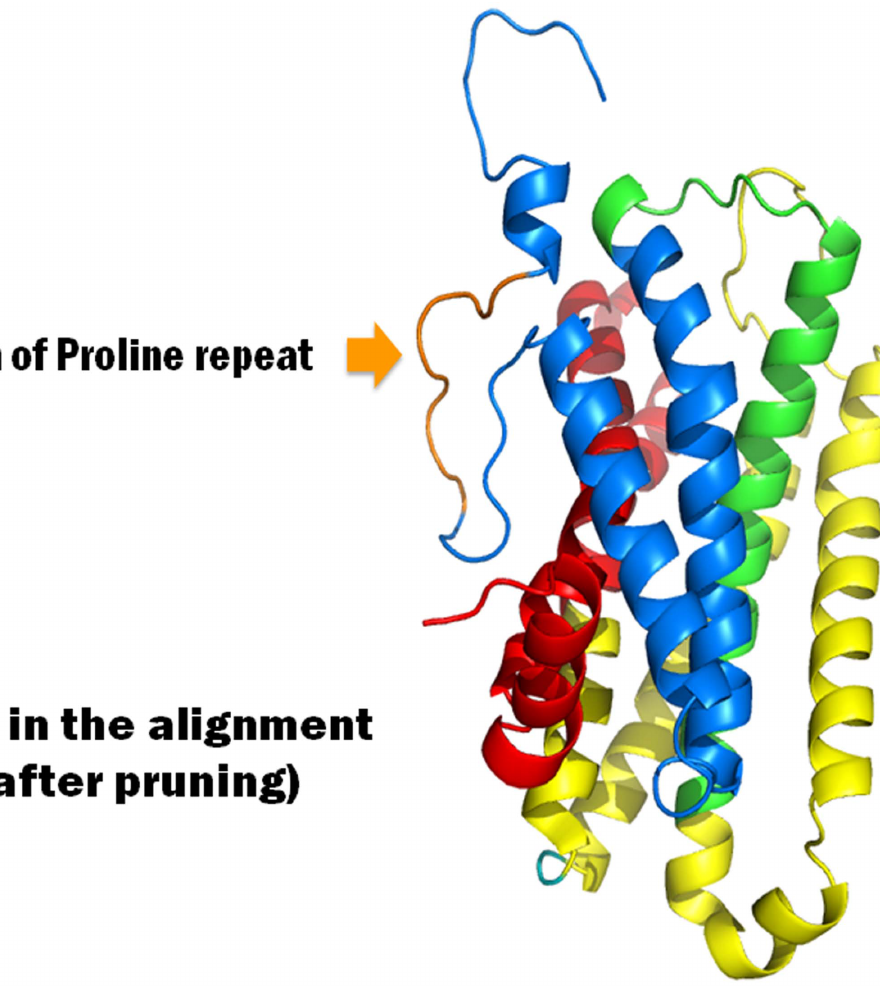
Figure 1. Three-dimensional structure of the DRD4 protein for domesticated chickens. The disordered region (arrow) is the region of proline repeats located on the outside of the cell membrane which receives dopamine released from the synaptic cell.